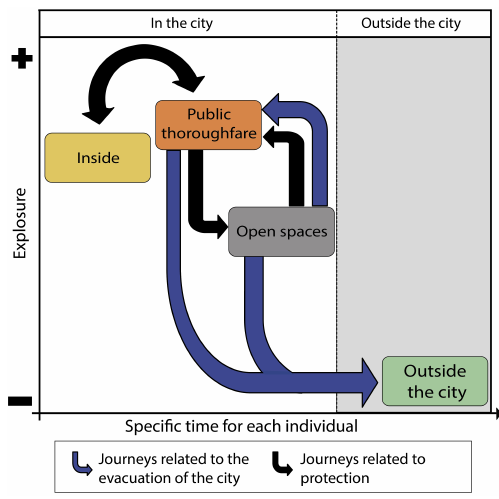
Figure 8. Conceptual model of mobility and exposure in a seismic crisis modify from (Rojo et al., 2013). A model developed from the analysis of the earthquake of 11 May 2011 in Lorca,